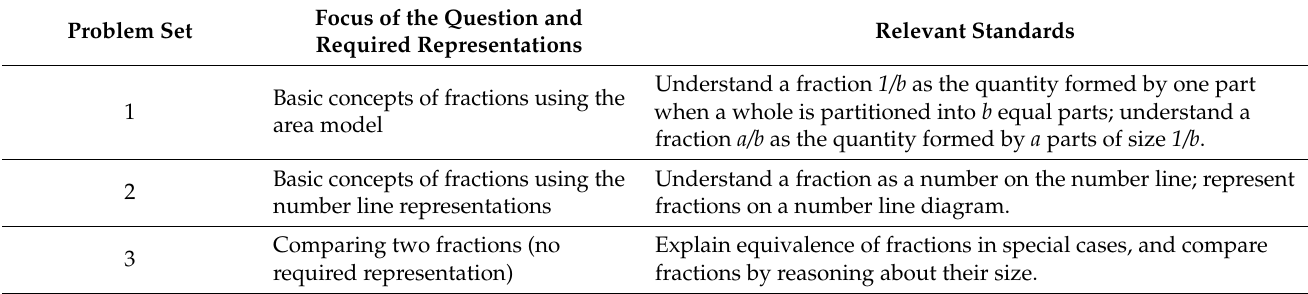
Table 2. Requirements for each set of